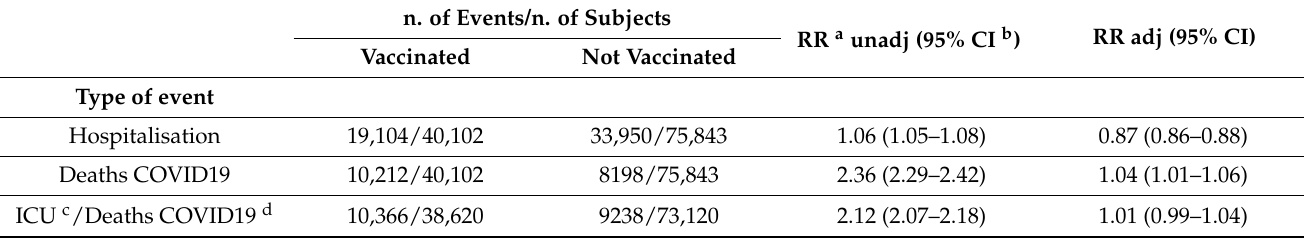
Table 3. Association between flu vaccination and COVID-19 related hospitalisation, mortality and admission to ICU plus mortality composite